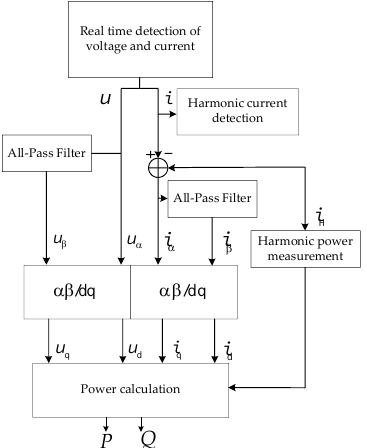
Figure 4. Calculation block diagram of expected power.